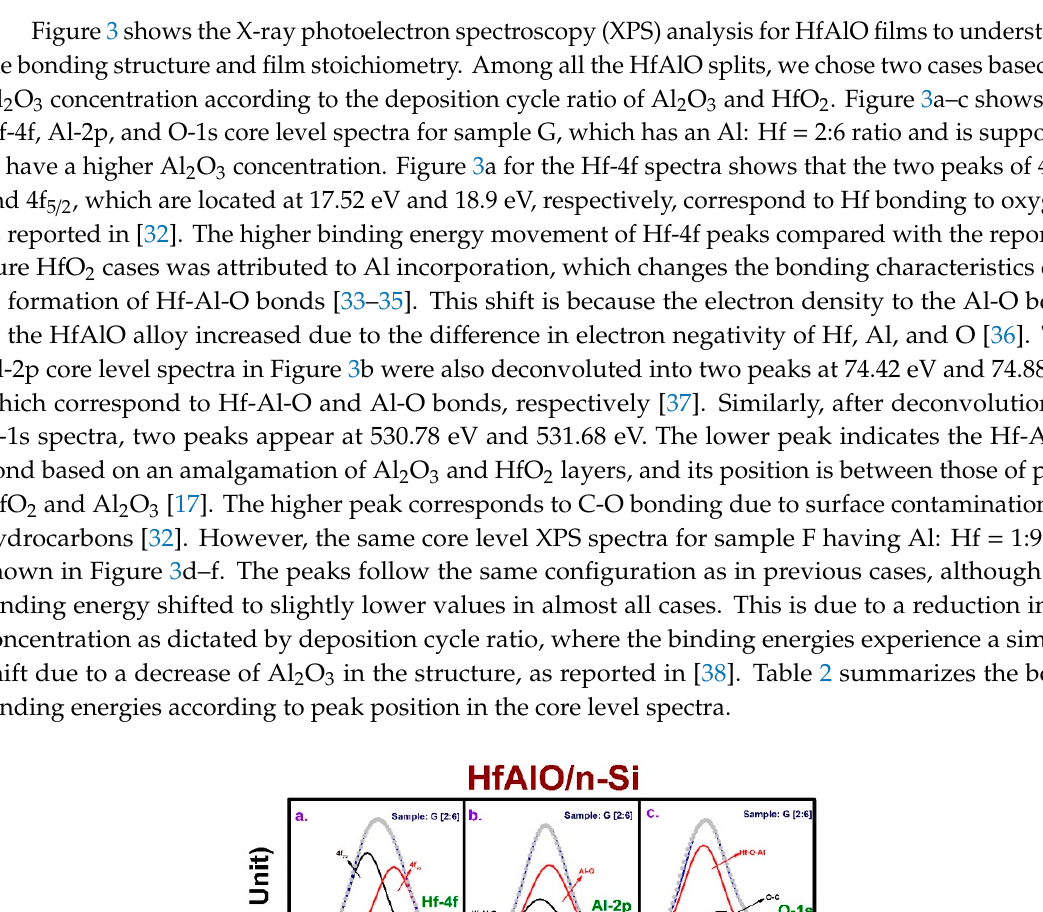
Figure 3. Hf-4f, Al-2p, and O-1s XPS core level spectra: ( a – c ) sample G (Al: Hf = 2:6) and ( d – f ) sample E (Al: Hf = 1:9).